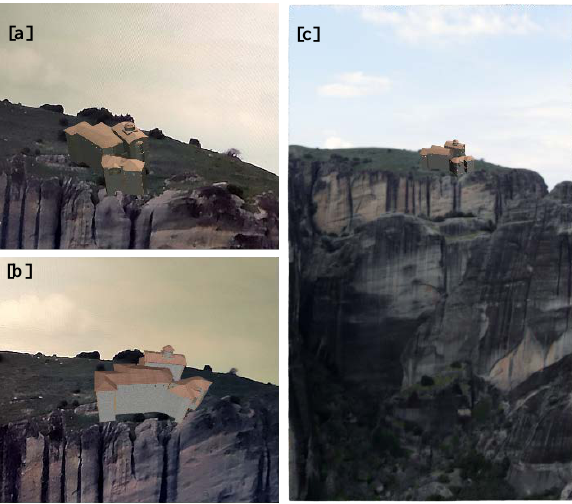
Figure 5. Screenshots of the overlaid 3D